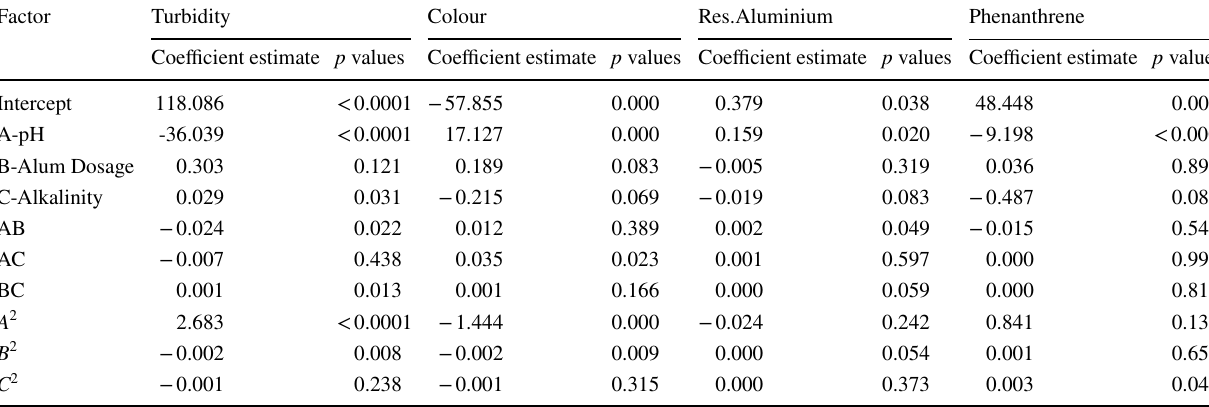
LOF lack of fit, SD standard deviation, CV coefficient of variation, PRESS prediction error sum of Table 6 Estimate of the model equation for the response results Factor Turbidity